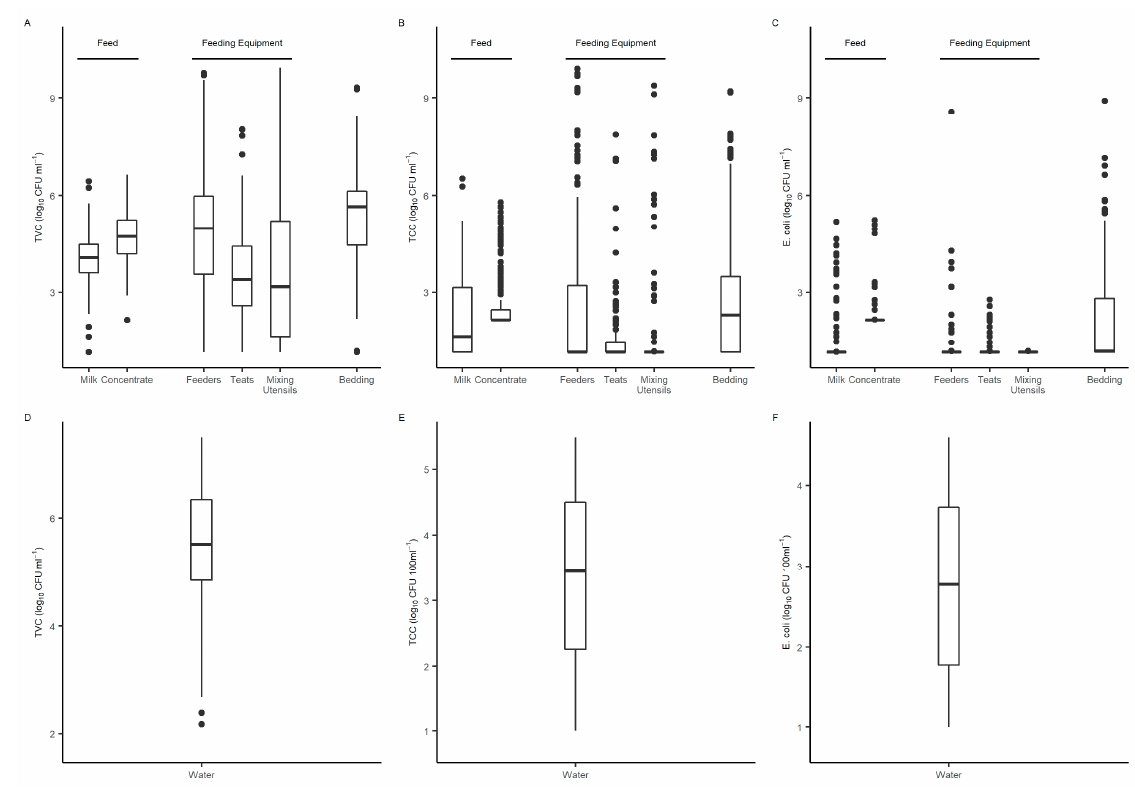
Figure 1. TVC ( A , D ), TCC ( B , E ) and E. coli ( C , F ) counts for calf milk/MR, concentrate feed, water, feeding equipment and bedding.